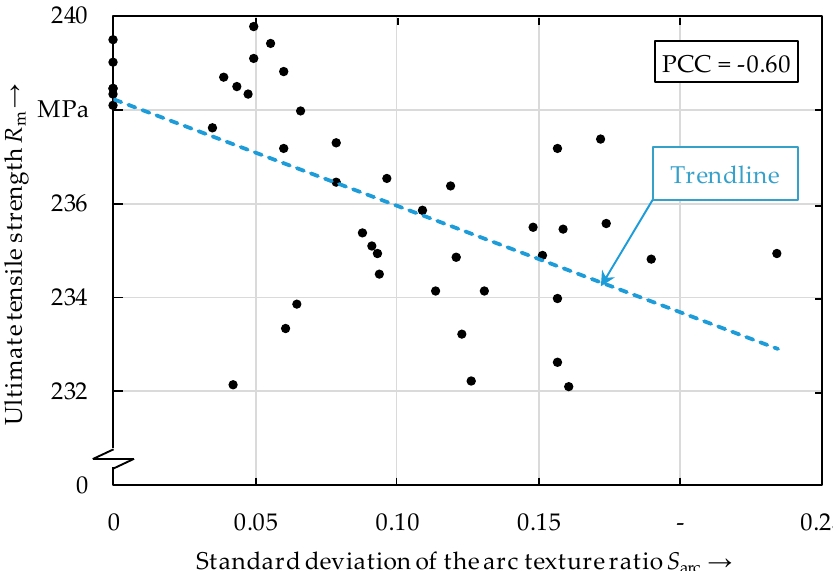
Figure 8. Ultimate tensile strength R m as a function of the standard deviation of the arc texture ratio S arc at a welding speed v s of 500 mm/min.